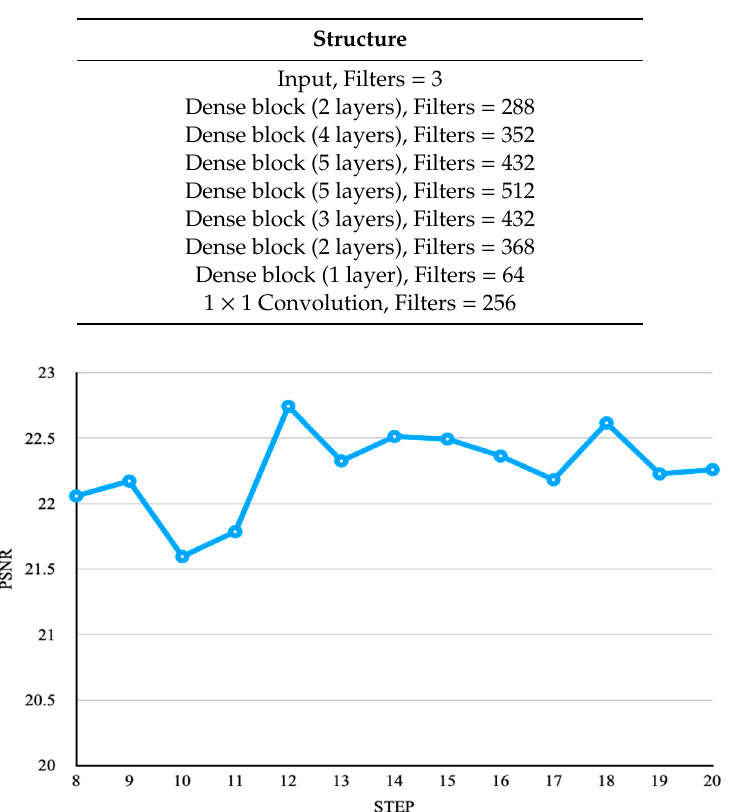
Table 3. DenseNet framework.